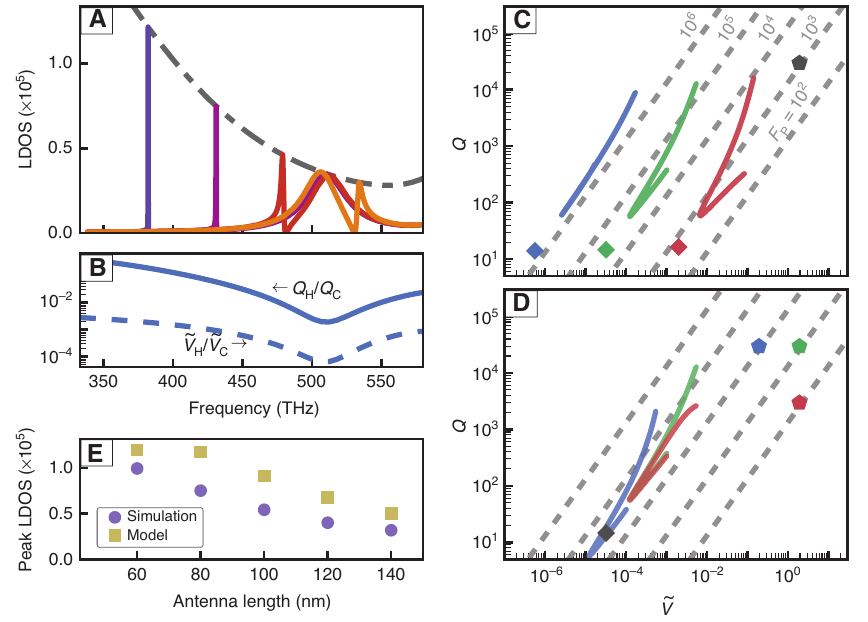
Figure 4: Hybrid design